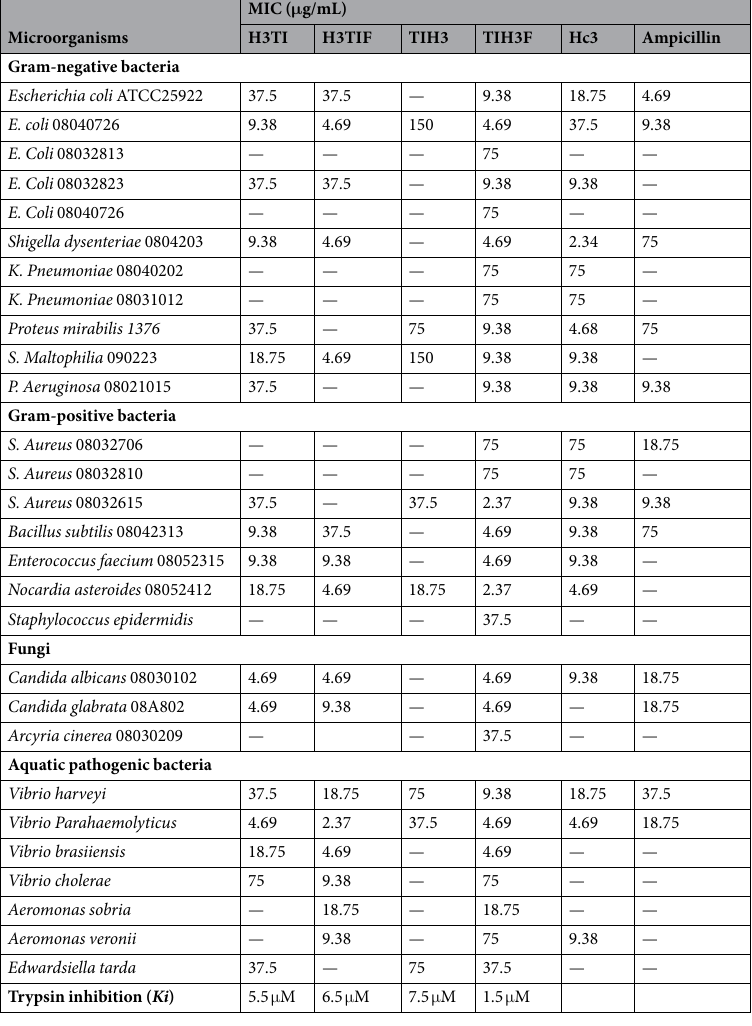
Table 4. Antimicrobial and trypsin-inhibitory activities of the four hybrid peptides. MIC: minimal inhibitory concentration. These concentrations represent mean values of three independent experiments performed in duplicates. —: no detectable activity in MIC assay in dose of 200 µ g/mL or in trypsin inhibition assay at concentration of 160 μ